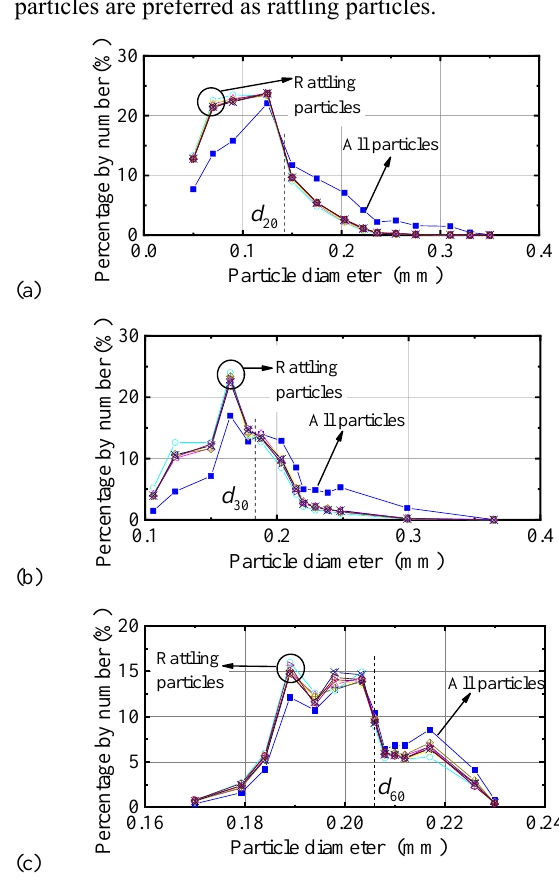
Fig. 5. Size distributions of rattling particles for different PSDs ( e 0 = 0.67): (a) PSD1, (b) PSD2, and (c)